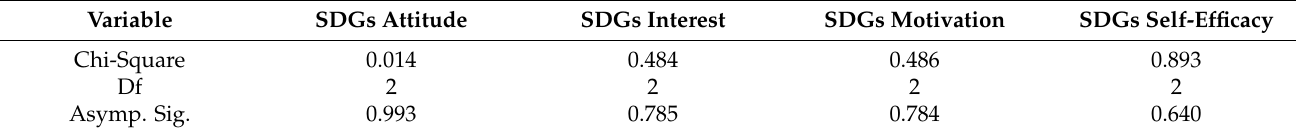
Table 9. Kruskal-Wallis test for major differences.